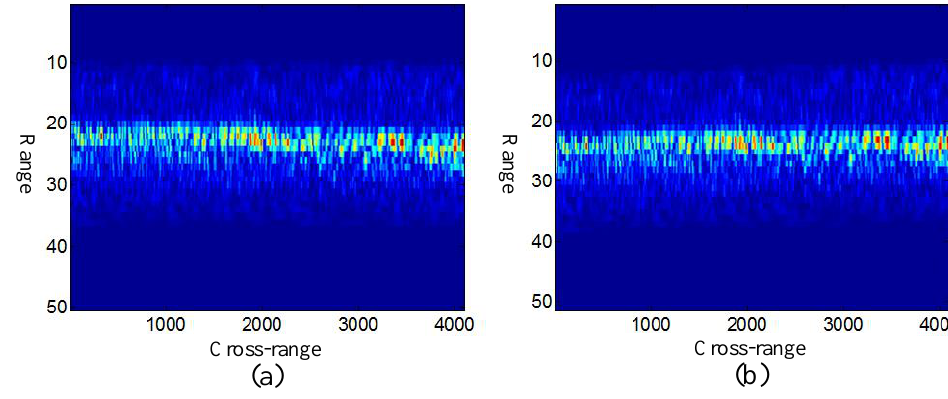
Figure 20. The envelope of T4. ( a ) Before RCMC. ( b ) After